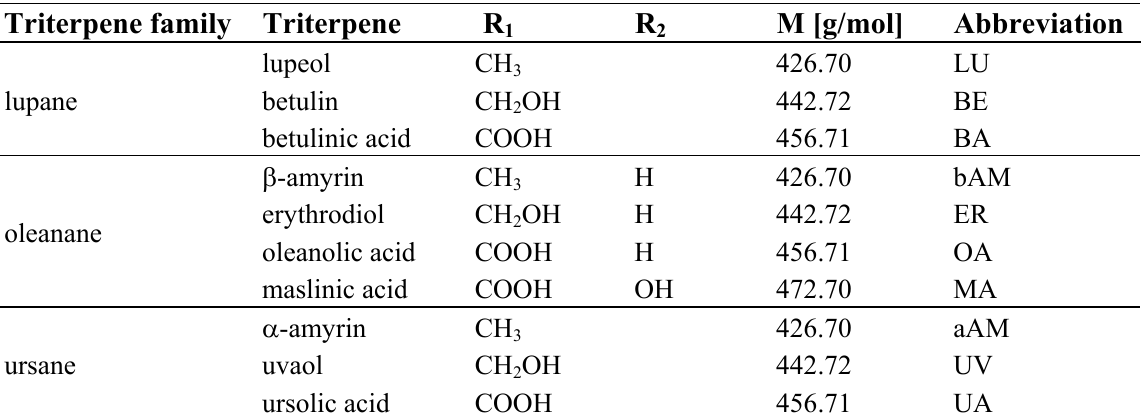
lupane oleanane ursane Table 1. Triterpene